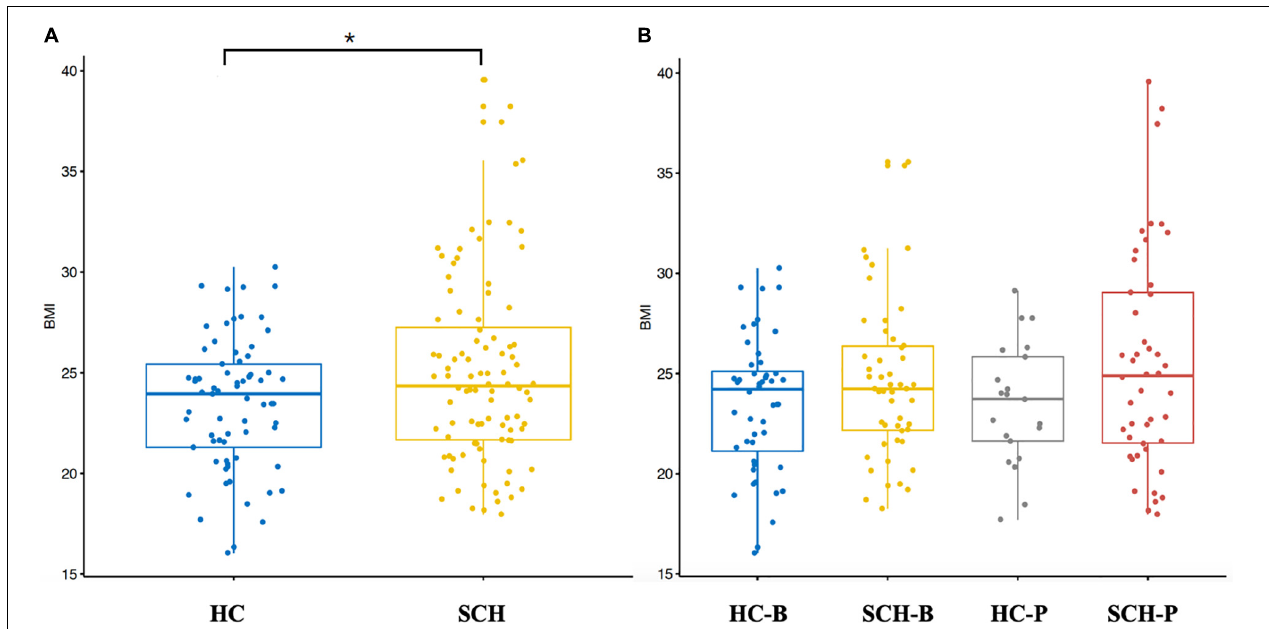
FIGURE 1 | Box-plot (A) independent sample t -test was conducted for the two groups. BMI of schizophrenia was significantly higher than that of the healthy controls. (B) All the subjects were divided into four groups based on the enterotypes. Through analysis of variance, it was found that BMI of schizophrenic patients with Prevotella type showed an increasing trend. * p < 0.05.